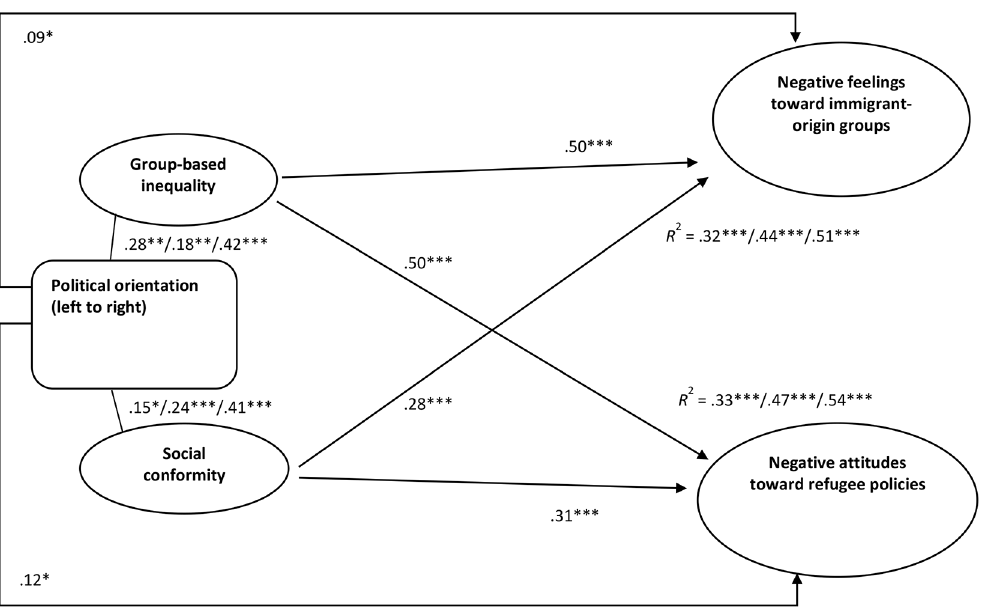
Figure 1. Standardized regression coefficients for the main paths of the model tested. Note. The associations between political orientation and social conformity and group-based inequality are presented per education level (low, medium,